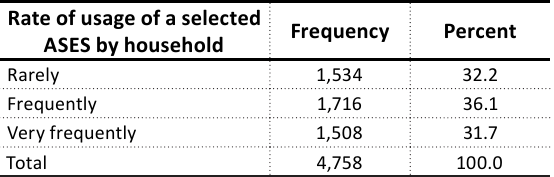
Table 17. Rate of usage of a selected ASES by